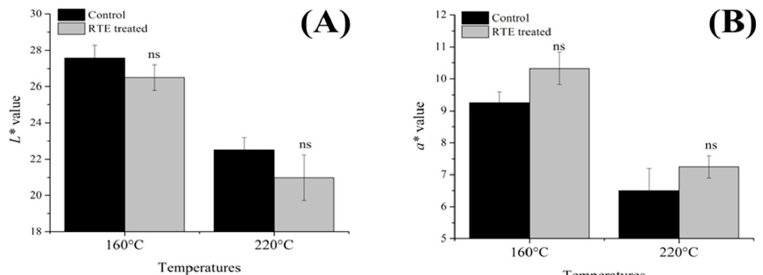
Figure 4. Effects of the Rosa rugosa tea extract (RTE) on the pH value; means ± SD of triplicate analyses; means bearing different letters (a, b) between control and RTE treated groups of single temperature indicate significant difference ( p < 0.05).